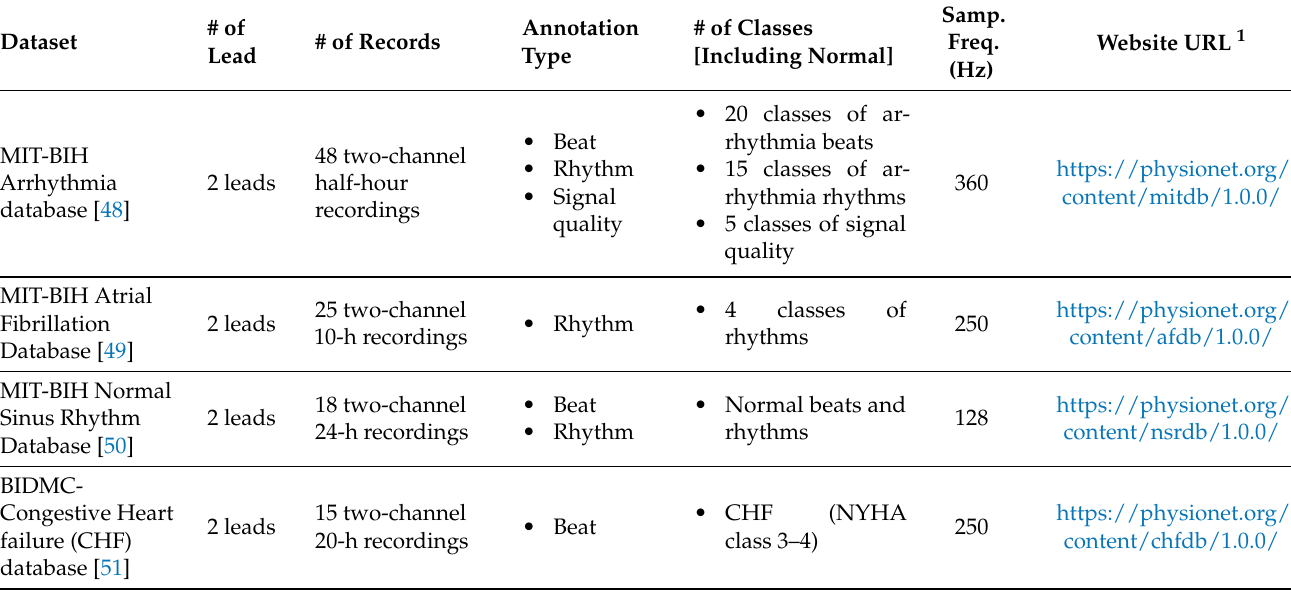
Table 5. Beat, rhythm, and signal quality level of the annotated heart ECG signal